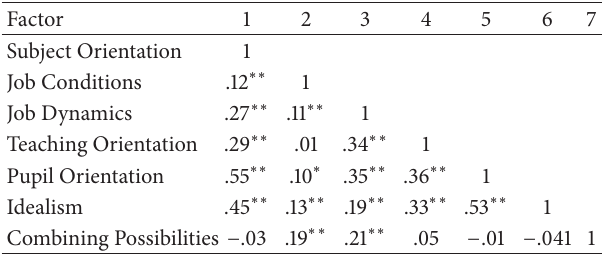
Table 5: Correlations between the